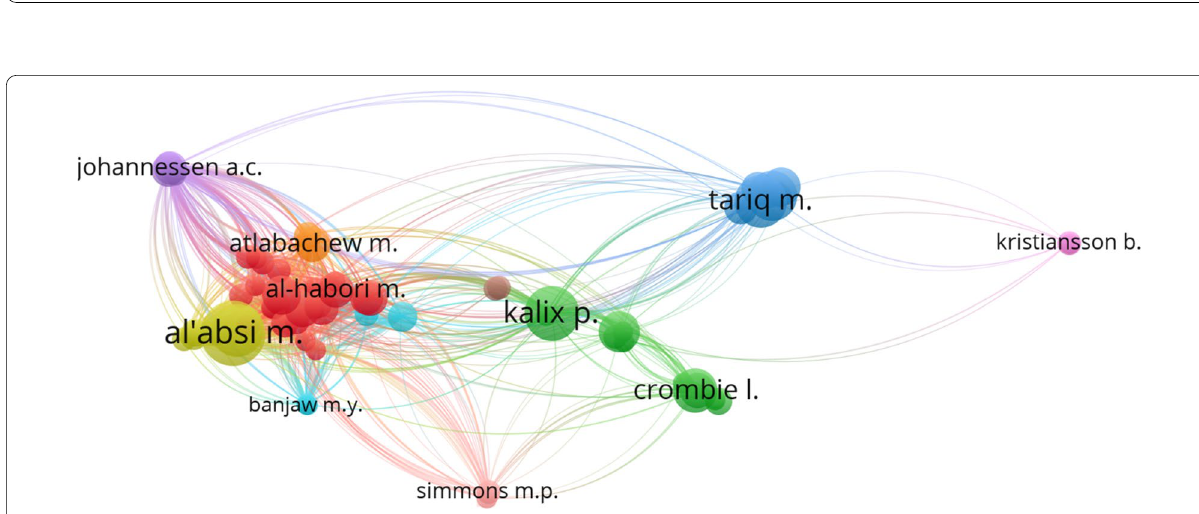
Fig. 14 VOSviewer visualization of a researcher’s bibliographic coupling